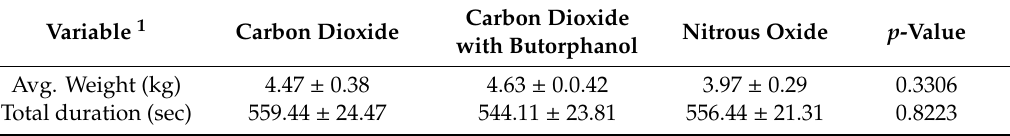
Table 2. Data collected (mean ± SE) on individual pigs for the three treatments.